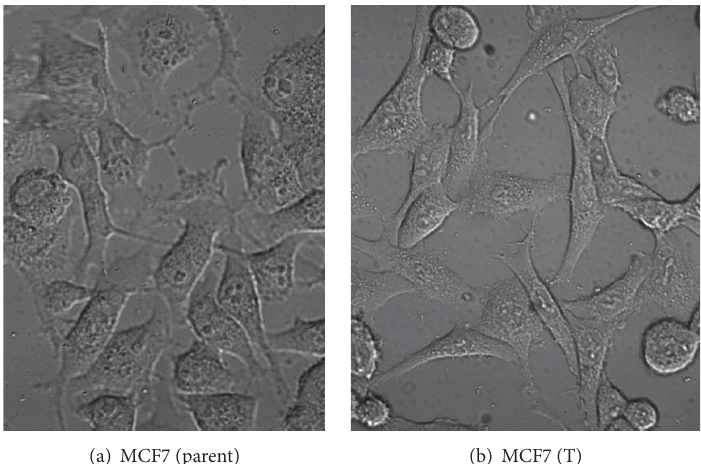
Figure 1: (a) Cell morphology of MCF7 cells (parent). (b)MCF7 (T) cells treated with tamoxifen 1 𝜇 M for 10 passages (44 days). Photographed under confocal microscope.